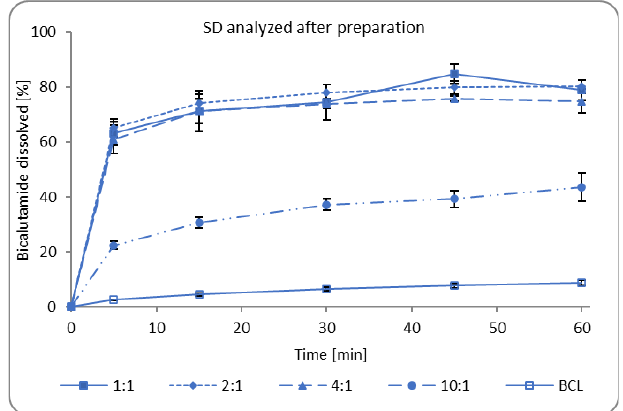
Figure 4. Dissolution of bicalutamide from the 1:1, 2:1, 4:1, 10:1 solid dispersions and for raw substance. The results were obtained for freshly prepared powder samples.